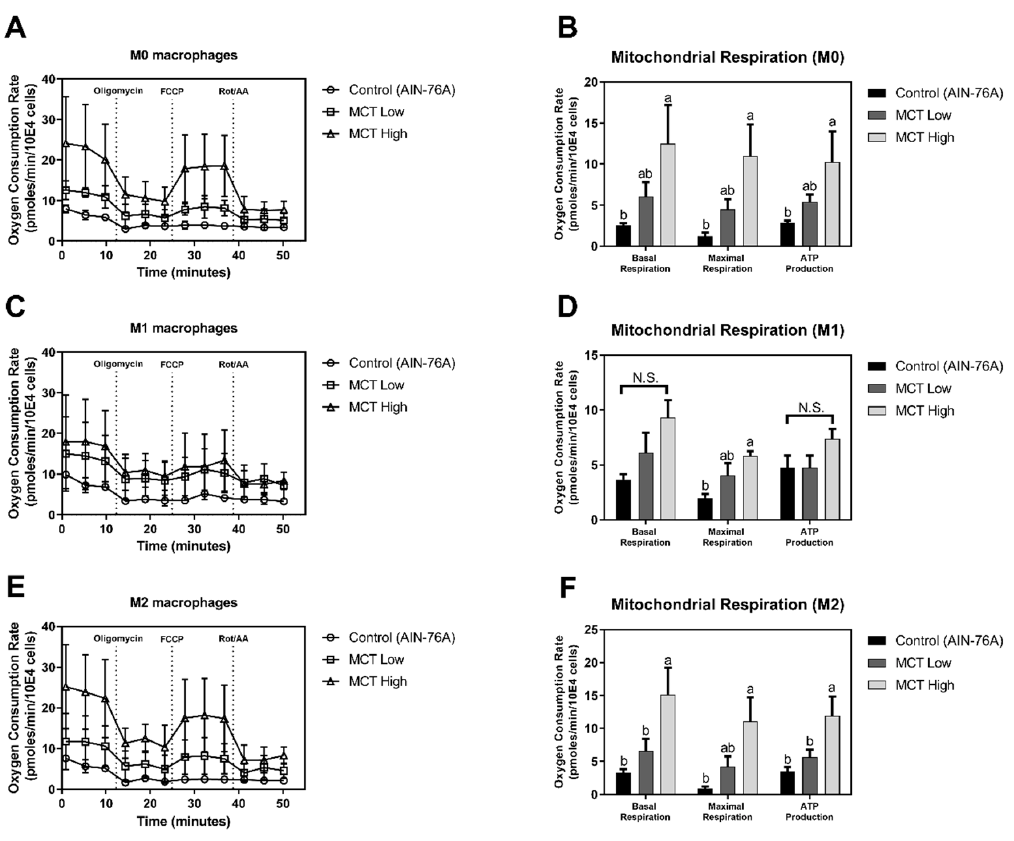
Figure 2. MCT upregulates OXPHOS in non-polarized and M2 polarized BMDMs. To assess OCR in non-polarized (M0) and polarized (M1 and M2) conditions, bone marrow-derived macrophages were collected from C57BL/6 mice fed with custom diets (AIN-76A, MCT Low, MCT High) and treated with macrophage colony-stimulating factor (M-CSF). Following stimulation with LPS/IFN- γ for M1 polarization or interleukin (IL)-4/IL-13 for M2 polarization, cells were transferred to Seahorse microplates for assessing OCR. OCR was assessed using a Seahorse Extracellular Flux analyzer in non-polarized ( A ), M1 ( C ), and M2 ( E ) polarized conditions. The mitochondrial respiration parameters (basal respiration, maximal respiration, and ATP production) were calculated and are presented as pmoles/min in each non-polarized ( B ), M1 ( D ), and M2 ( F ) polarized BMDMs. Data are indicated as mean ± SEM ( n = 4), and significant differences are indicated with different letters ( p < 0.05, N.S. means no significant difference) within each basal respiration, maximal respiration, and ATP production column (B, D, and F).